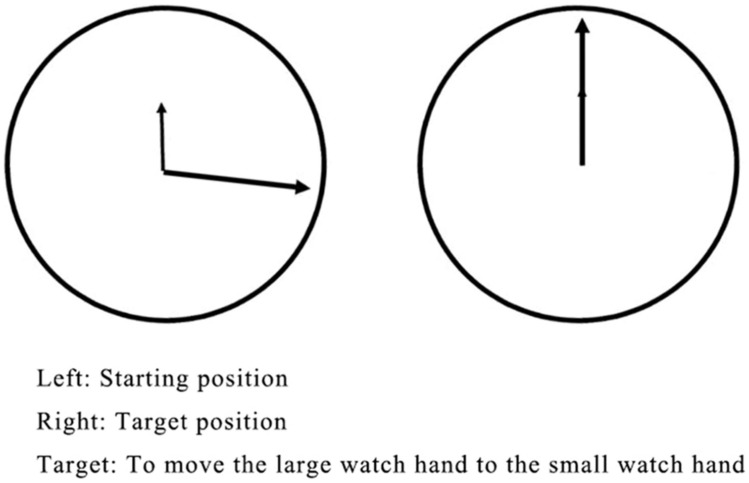
The control task.